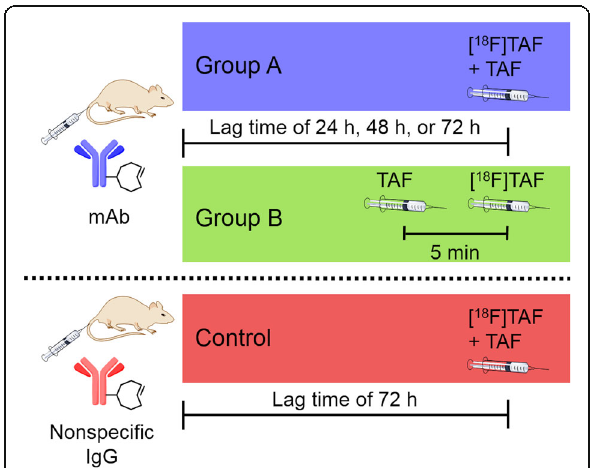
Fig. 3 Experimental scheme for pretargeted imaging studies. Both mAb groups (A and B) and the nonspecific IgG control received the same mass of antibody via lateral tail vein injection. In the mAb pretargeting experiments, the same total molar amount of non- radioactive TAF was given to each animal after the designated lag time of 24, 48, or 72 h either by mixing it directly to the [ 18 F]TAF injection and reducing its molar activity (group A, n = 4) or by giving the non-radioactive TAF 5 min prior to administration of [ 18 F]TAF (group B, n = 4). The lag time of 72 h and the single administration of the tracer was chosen for the experimental setup for nonspecific IgG control ( n = 5) corresponding to the conditions in which the mAb pretargeting was the most